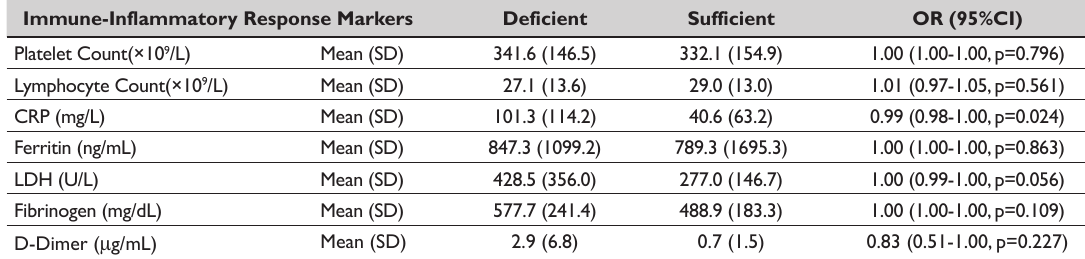
Table 6: Comparative analysis of the association between serum vitamin C levels and immune-inflammatory response markers Immune-Inflammatory Response Markers Deficient